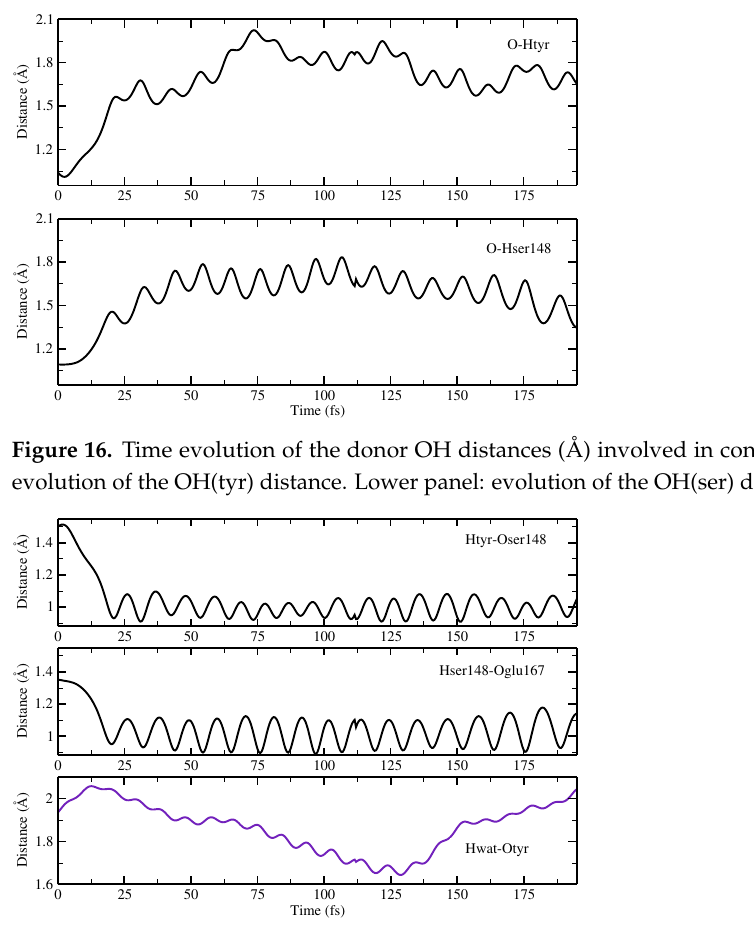
Figure 17. Network distance (Å) evolution involved in concerted PT showing the time evolution of the H(tyr)-O(ser) distance (upper panel), H(ser)-O(glu) distance (middle panel), and H(wat)-O(tyr) distance (lower